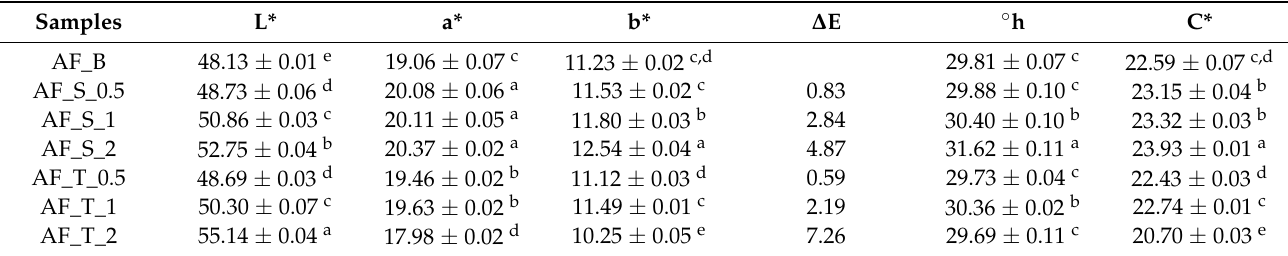
Table 4. Color parameters of formulated